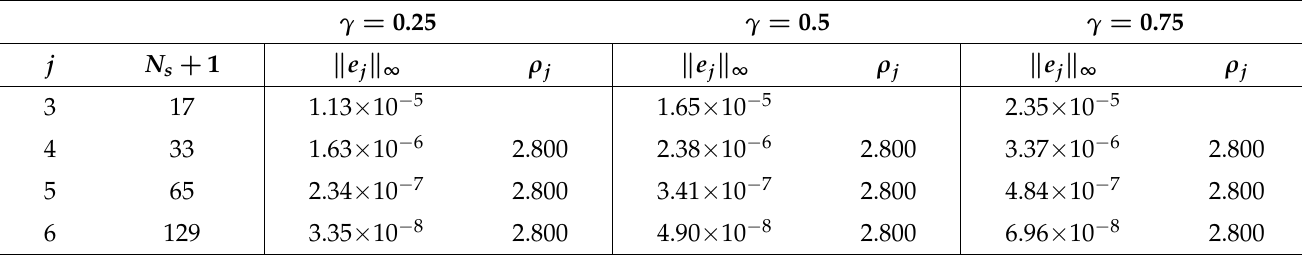
Table 2. Example 1: The infinity norm of the error and the numerical convergence order for different values of the fractional derivative γ and the refinement level j when using dQ 3 j y with r = 1 (cf. (26)). The number of collocation points is N s + 1 = 2 j + 1.